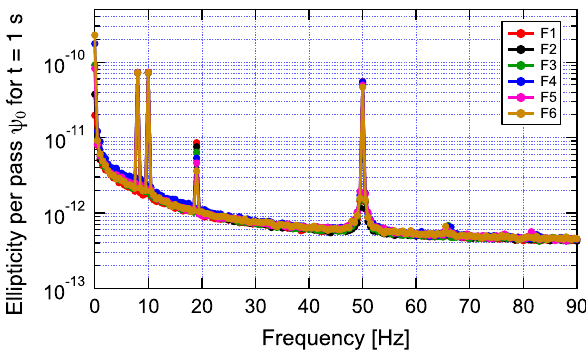
Fig. 11 ThesixellipticityspectraofFig.10rescaledassuminganellip- ticity noise S (cid:8) proportional to N and taking into account the frequency response of the cavity